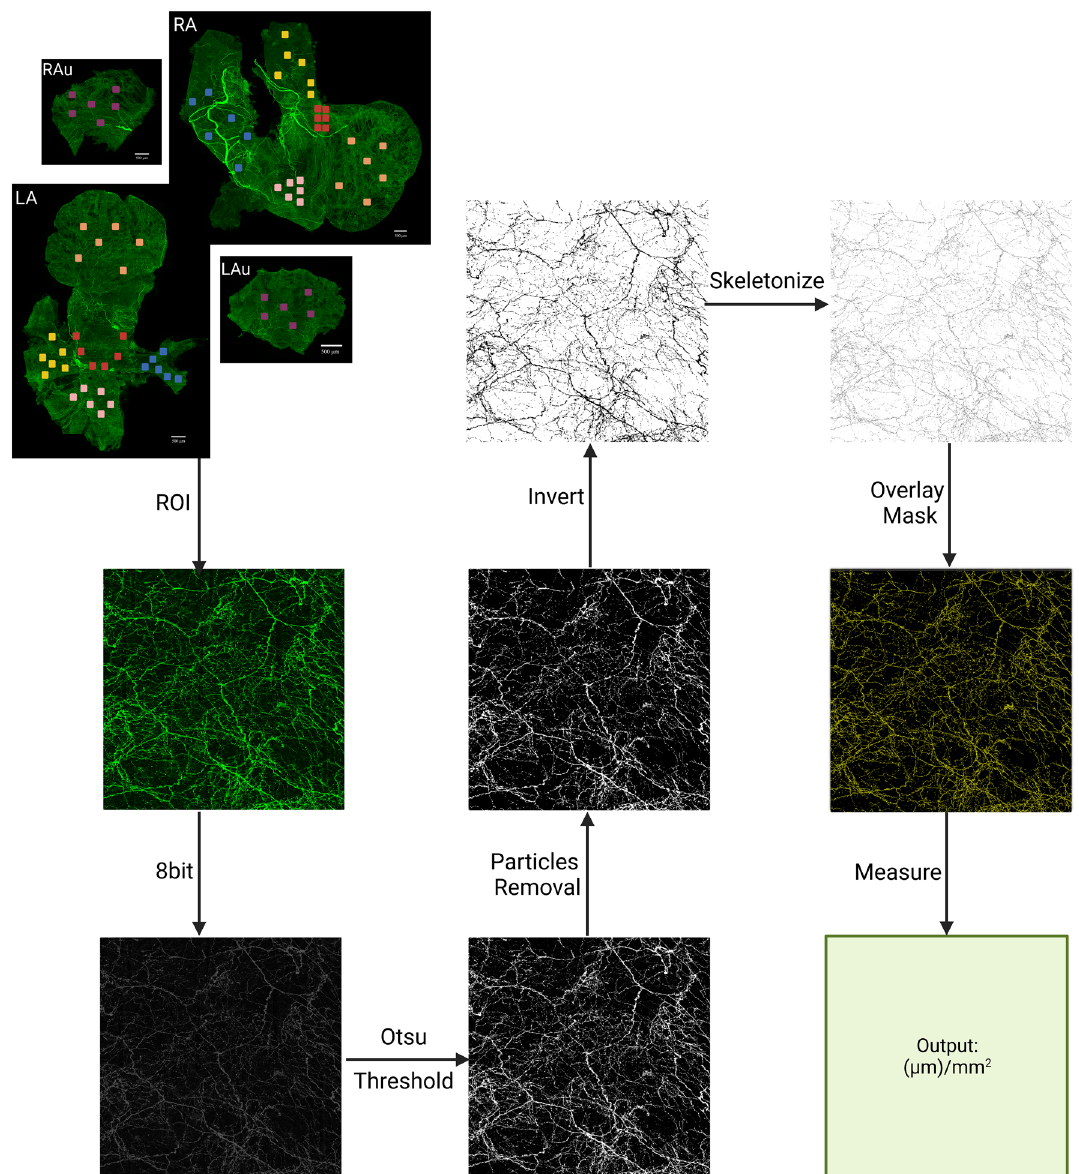
Figure 1. Pipeline for calculation of TH-IR axon density. Six frames within each region of interest (ROI) were selected, converted to grayscale, thresholded using Otsu algorithm, skeletonized and the signal pixels were measured in each ROI to represent total length of axons travelled in each